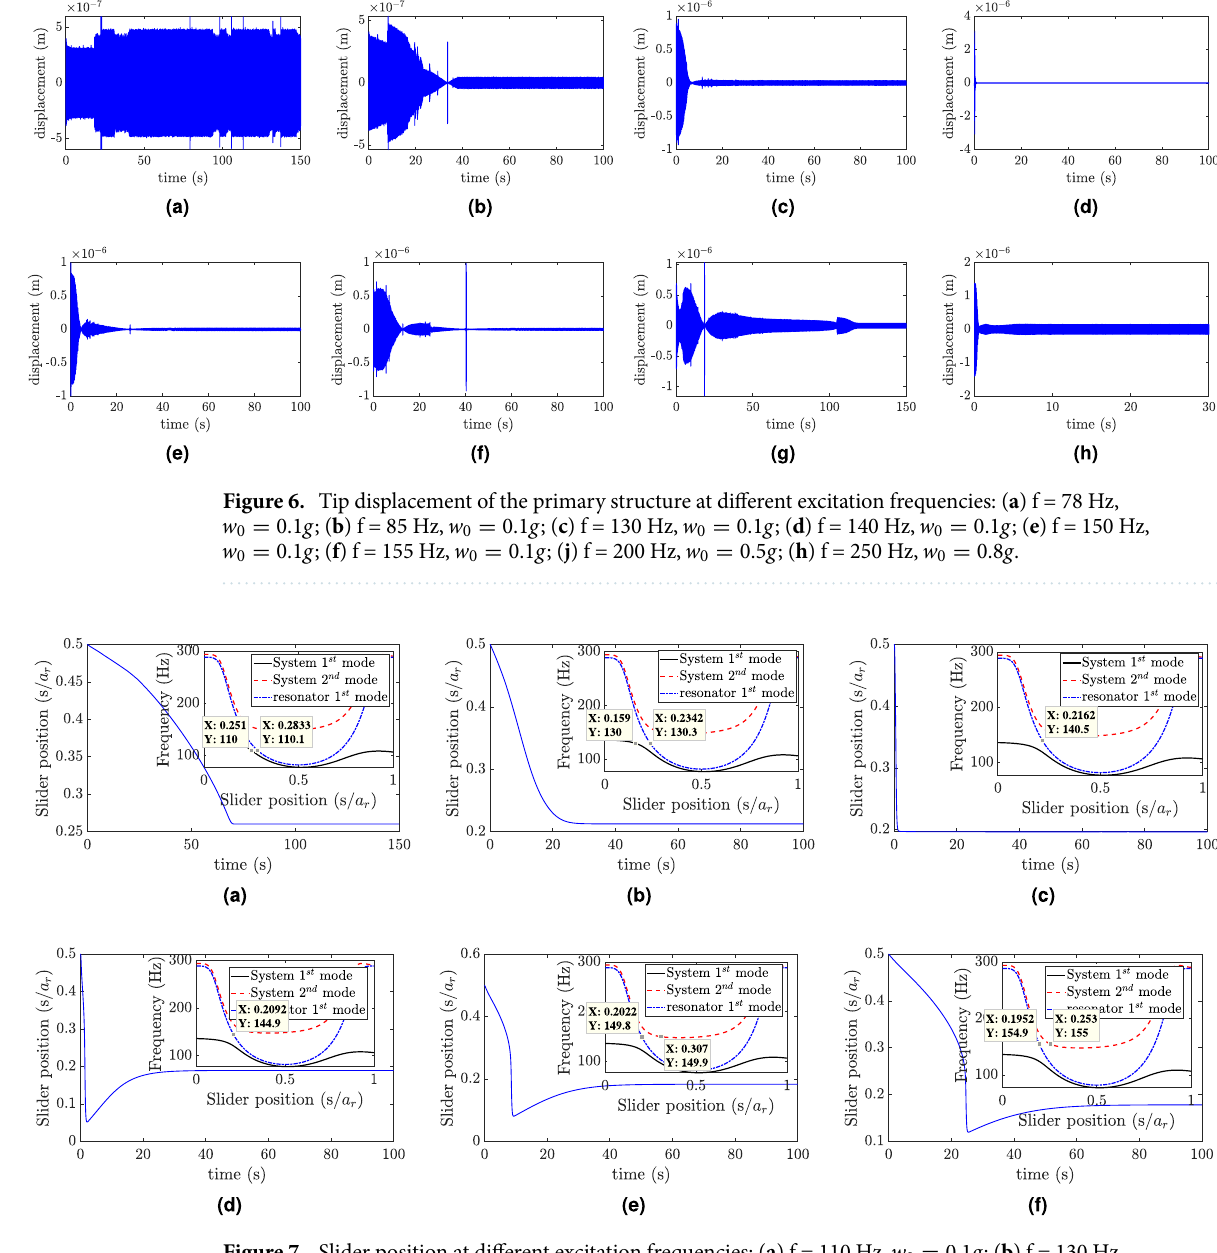
Figure 7. Slider position at different excitation frequencies: ( a ) f = 110 Hz, w 0 = 0.1 g ; ( b ) f = 130 Hz, w 0 = 0.1 g ; ( c ) f = 140 Hz, w 0 = 0.1 g ; ( d ) f = 145 Hz, w 0 = 0.1 g ; ( e ) f = 150 Hz, w 0 = 0.1 g ; ( f ) f = 155 Hz, w 0 = 0.1 g